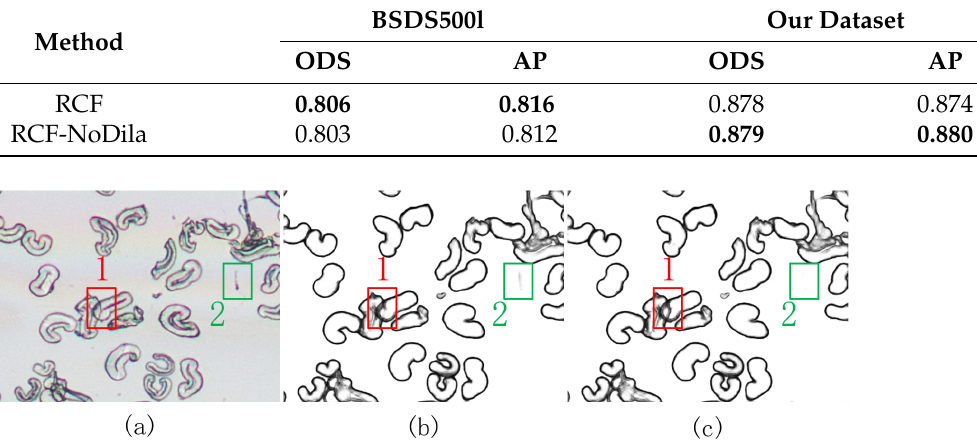
Figure 10. The influence of dilated convolution on different datasets. ( a ) The original image. ( b ) RCF. ( c )